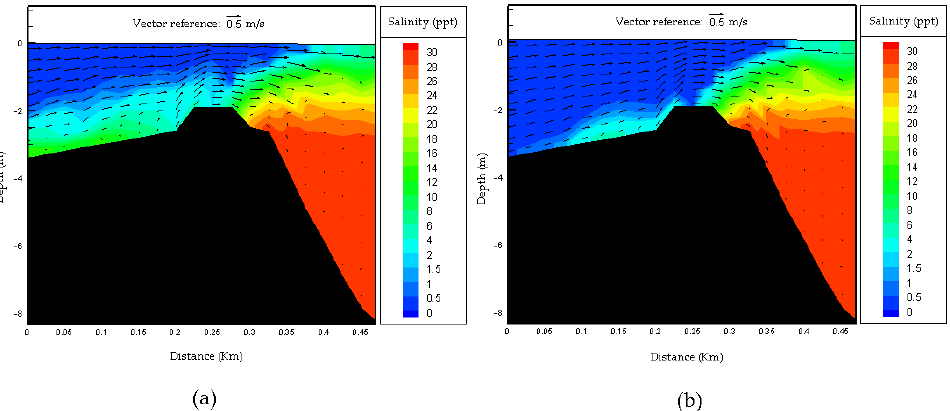
Figure 7. Current pattern on the vertical cross section for discharge of 36 m 3 /s ( a ) low slack water condition and ( b ) high slack water condition.